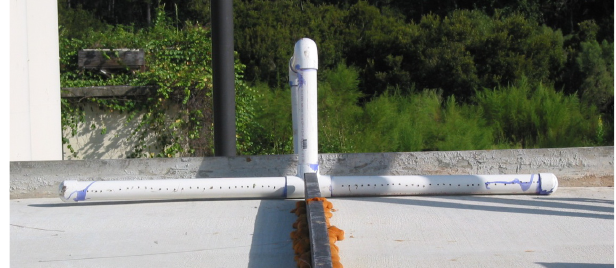
Figure 4. PVC piping system used to create sheet flow over simulated roadway.